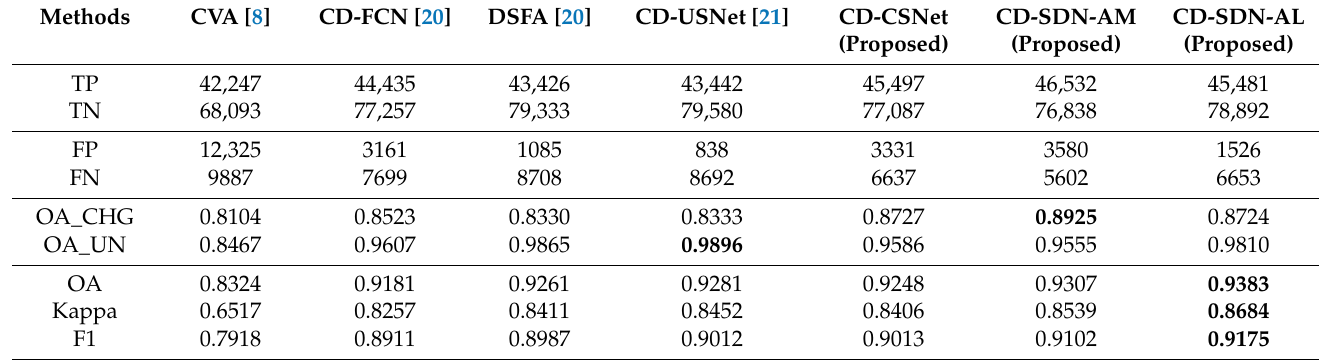
Table 1. The comparison of quantitative results on dataset ‘Santa Barbara’.